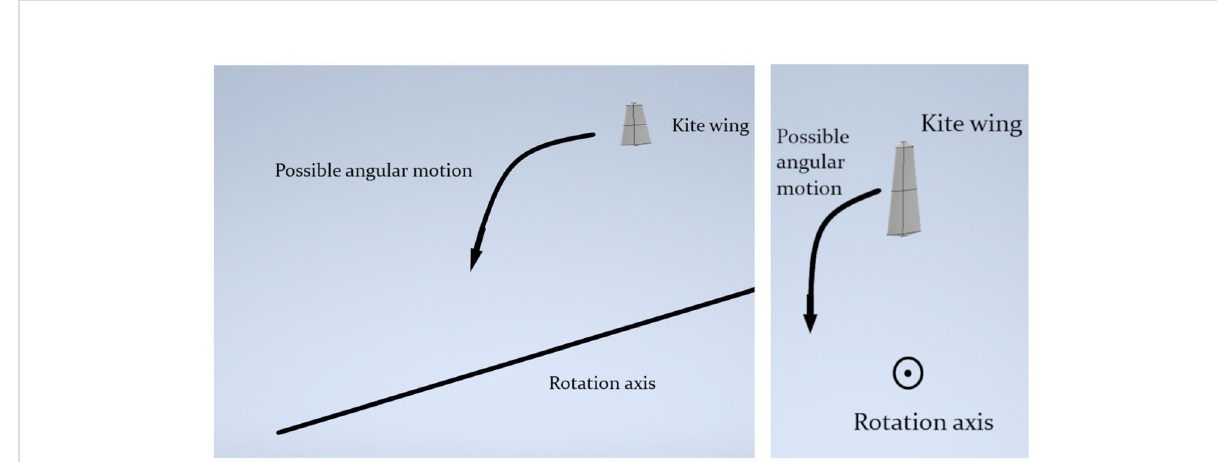
FIGURE 5 The setup for the motion simulation of the TUSK. The TUSK fl ies around a rotation axis at a given distance.